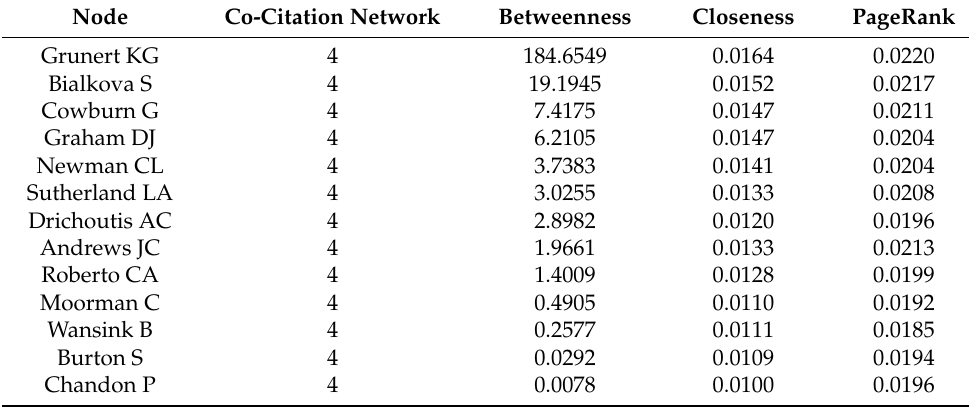
Table 13. The relative strength of the nodes within the co-citation network 4. Node Co-Citation